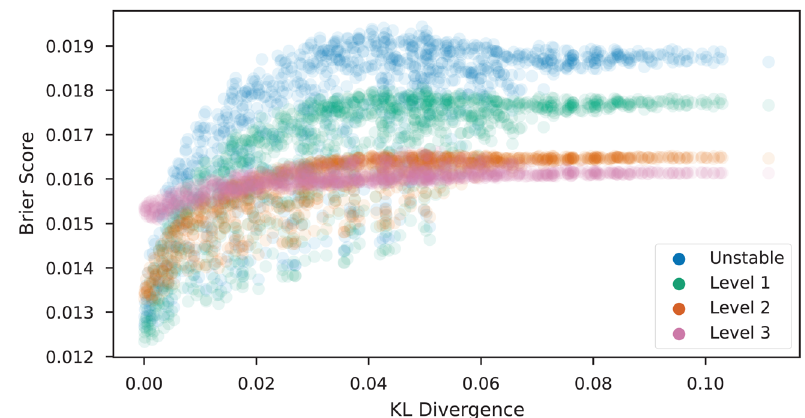
Figure 5: Performance ( Brier score ) of di ff erent models vs KL - divergence of new environment distribution from training dis - tribution under a mechanism shift to the lab ordering policy. The level 3 model is minimax